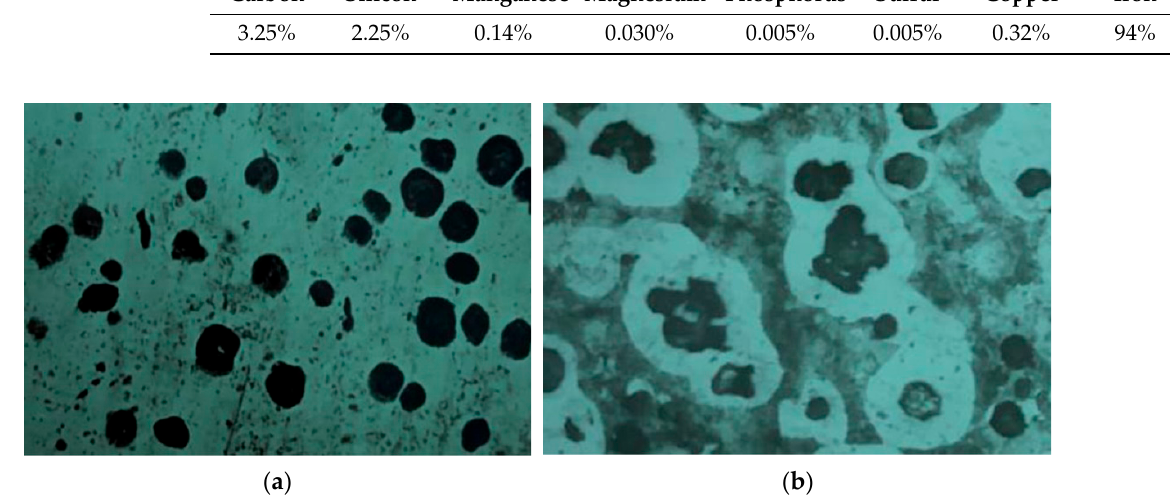
Figure 1. Microstructure of ductile cast iron ( a ) before etching ( b ) after etching (Magnification: 136×) . Table 1. The chemical composition of ductile cast iron.